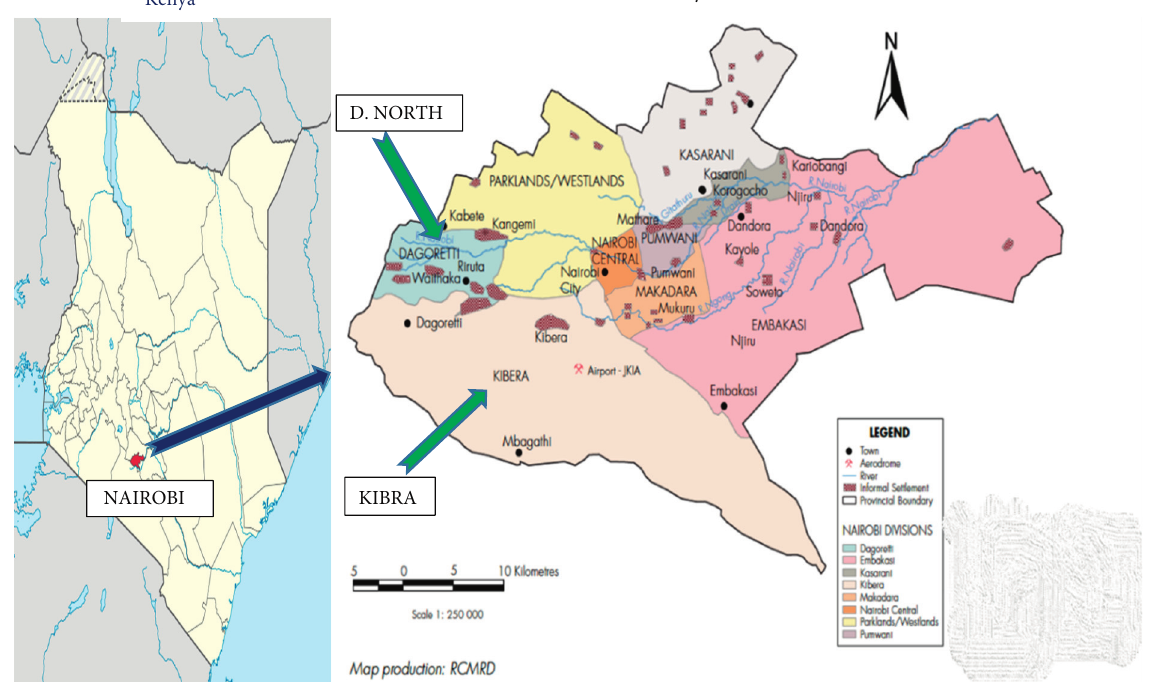
Figure 1: Location of Kibra and Dagoretti North from Nairobi County